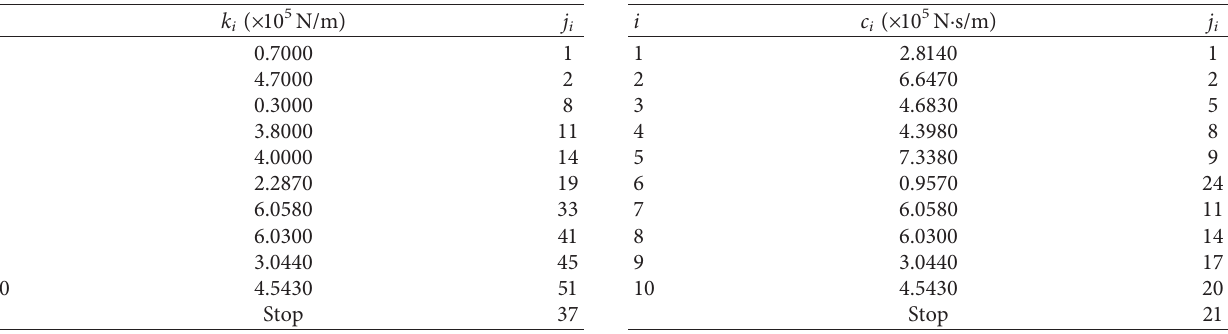
Figure 5: Walking results with different controllers. (a) Step-length control substrategy. (b) Velocity control substrategy. (c) The whole Table 5: Distribution of the coefficients of stiffness of the compliant ground.